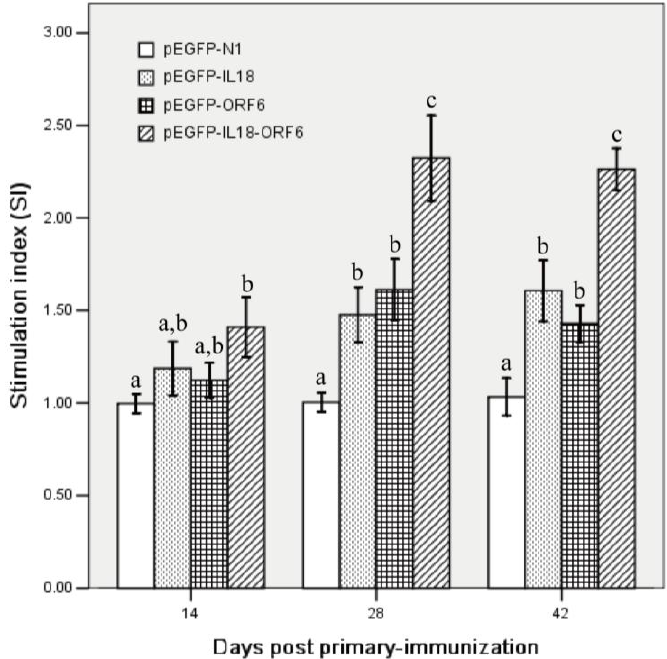
Figure 5. Lymphocyte proliferation responses of piglets immunized with different recombinant plasmids. Blood samples ( n = 5) were collected at various time-points and were stimulated with PRRSV protein in triplicate. Data are presented as the mean ± S.D. Different letters (a, b, c) above the columns at the same time point indicate significant difference ( P < 0.05) between the treatments.